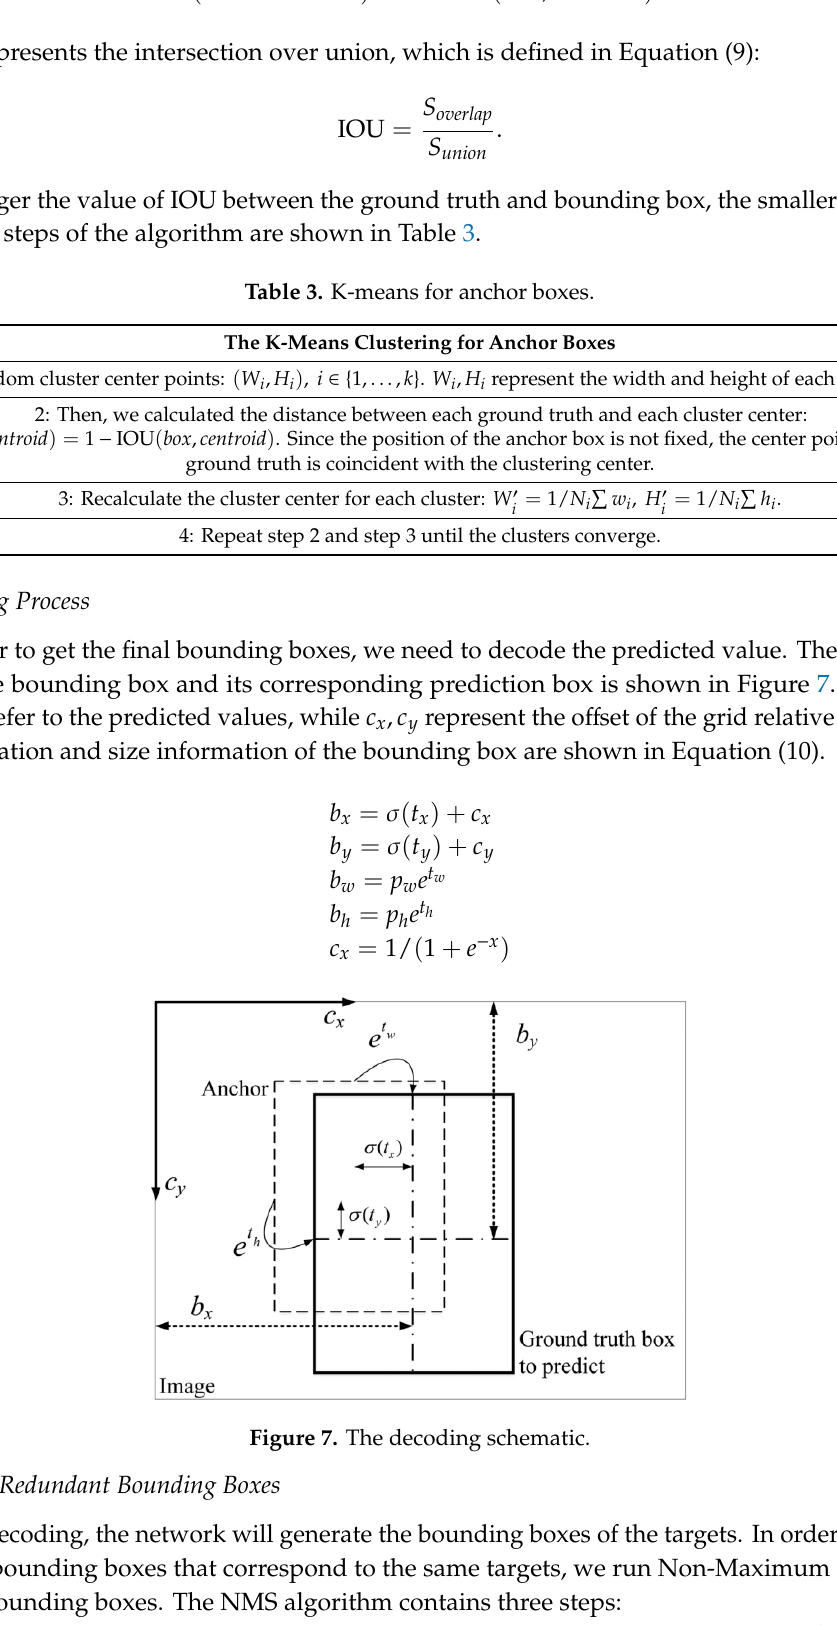
Figure 7. The decoding schematic.